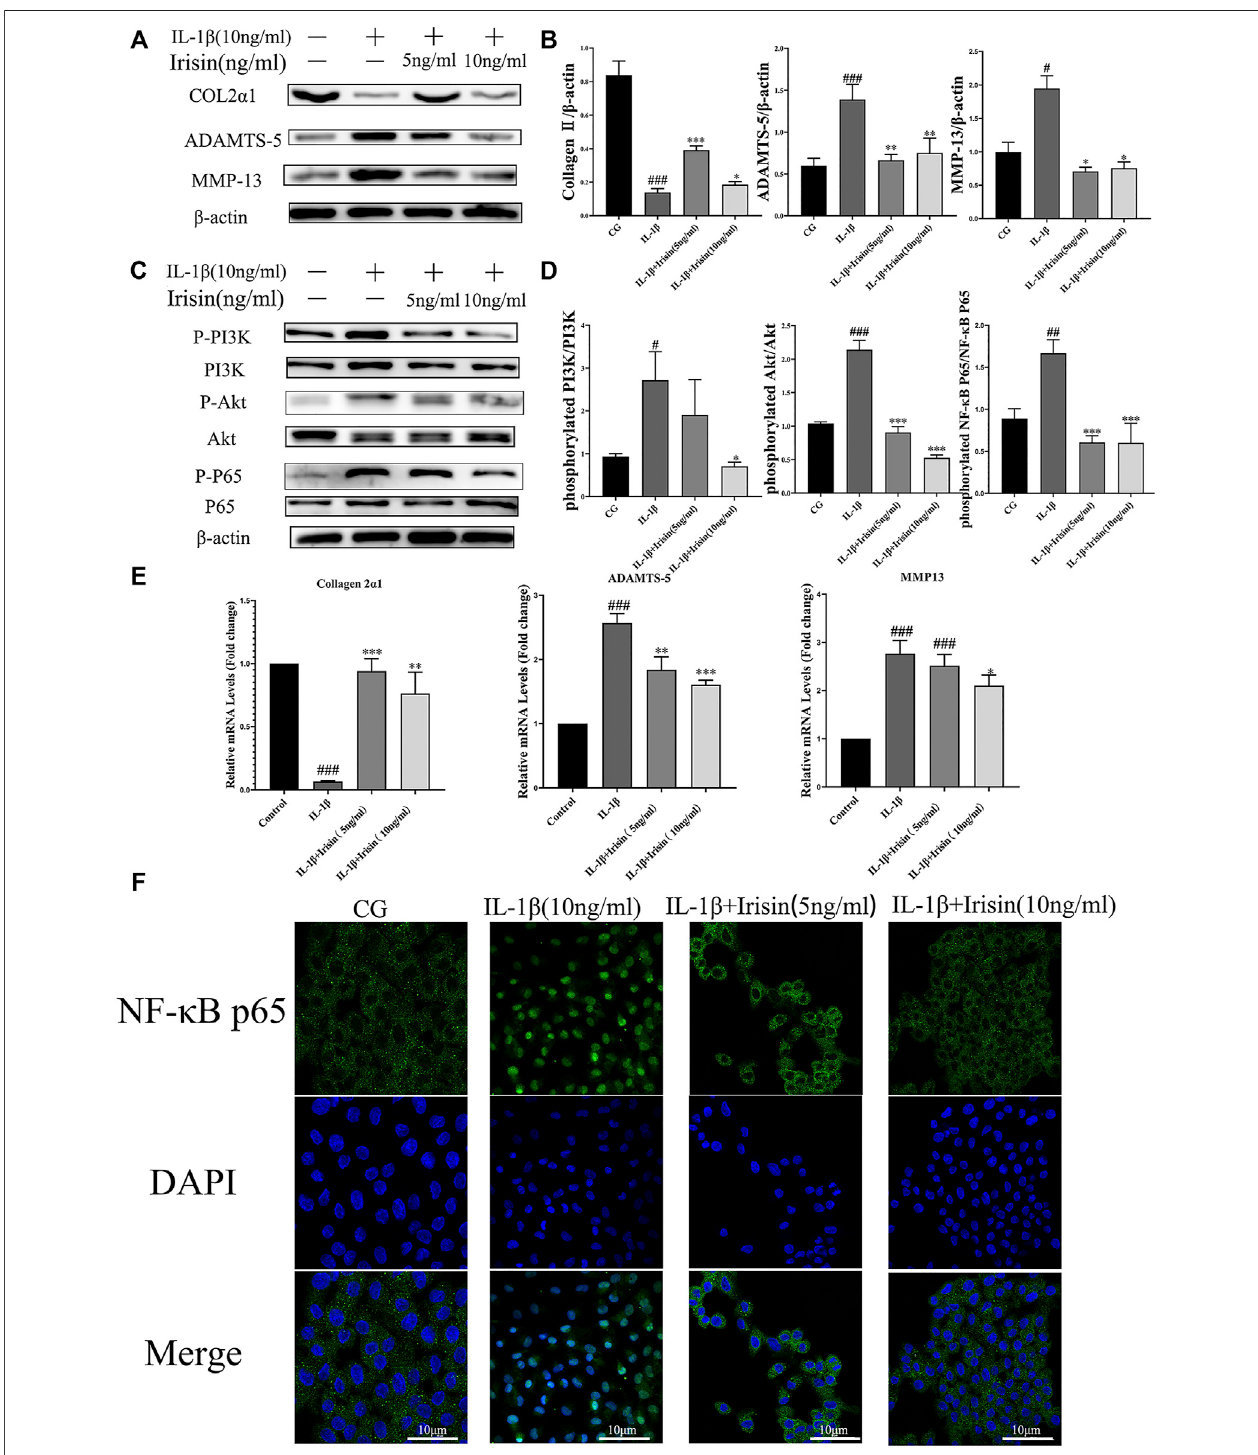
FIGURE 5 | Expression of in fl ammation-related markers and immuno fl uorescence analysis of NF- κ B p65 in chondrocytes. (A – D) The relative protein expressions weredetectedinthecontrol(CG),IL-1 β group,IL-1 β +irisin(5 ng/ml),andIL-1 β +irisin(10 ng/ml)groups.Chondrocyteswerepreincubatedwithdifferentconcentrations of irisin (0, 5, or 10 ng/ml) and treated with IL-1 β (10 ng/ml) for 24 h. The levels of expression of ADAMTS-5 and MMP-13 were increased after treatment with IL-1 β , whereasdecreasedaftertreatmentwithirisin.Inaddition,irisin-treated chondrocytes couldpartiallyrecover theexpression ofchondrocyte-speci fi ccollagenII.The phosphorylation of PI3K, Akt, and NF- κ B p65 was signi fi cantly suppressed in the irisin-treated group compared with that in the IL-1 β group. (E) Relative mRNA